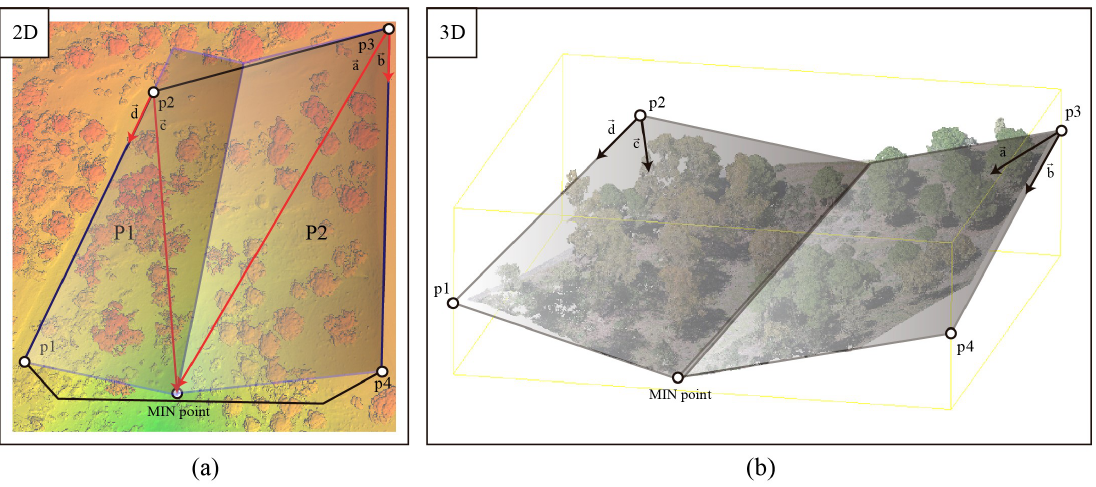
Figure 6. The ground removal determined by two cutting-planes (P1 and P2). ( a ) The representation of planes on the elevation map; and ( b ) The position and orientation of planes in